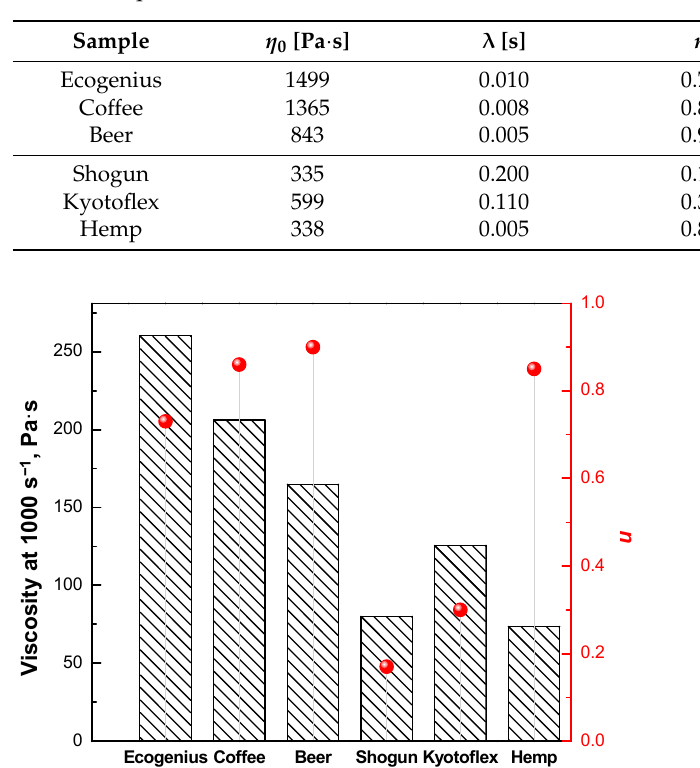
Figure 3. Viscosity values (bars) calculated at the actual shear rate value (i.e., 1000 s − 1 ) experienced during the flow in the printing nozzle, and values of the parameter n of the Carreau model (red symbols) for all investigated PLA-based materials.